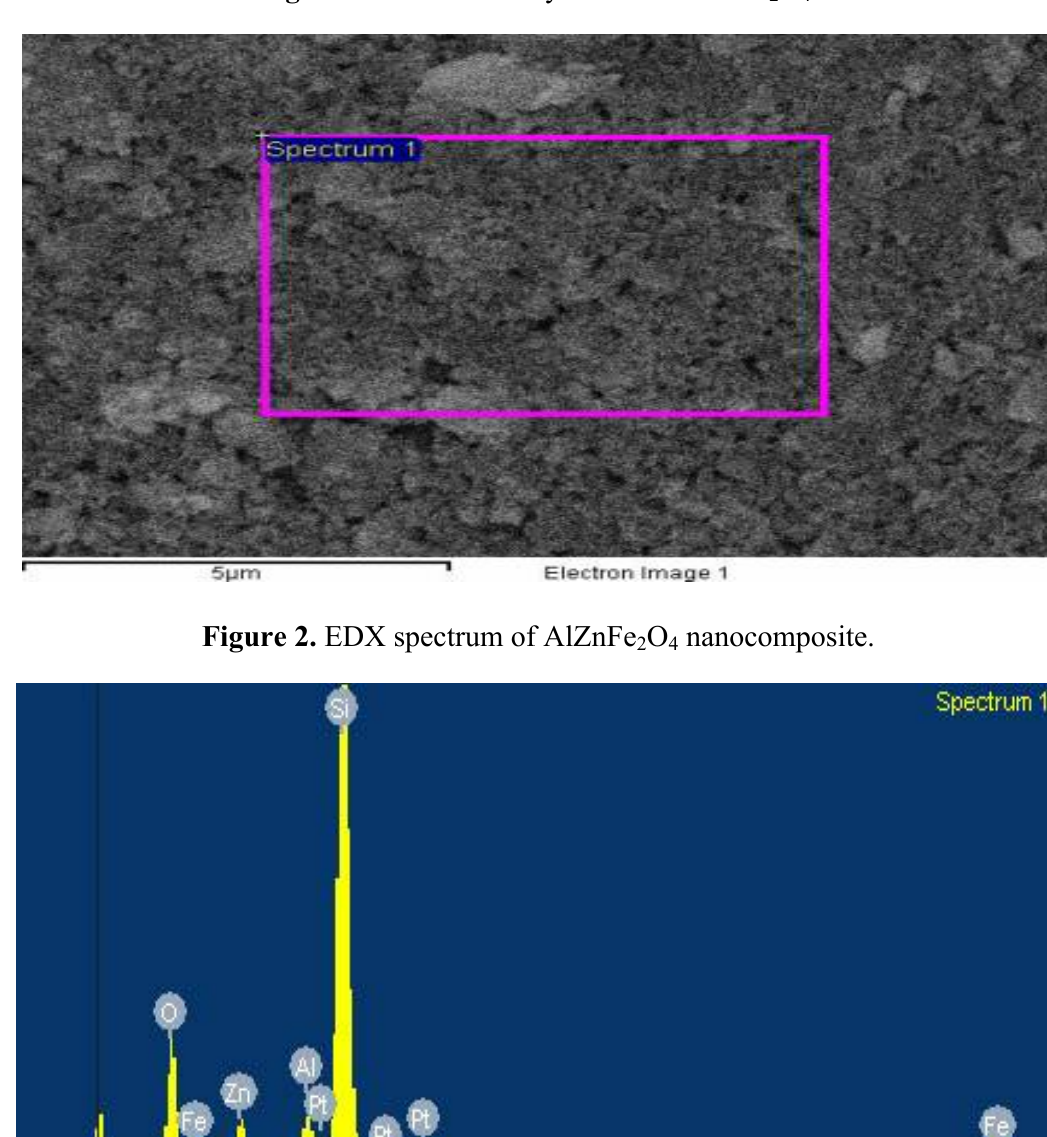
Figure 1. FE-SEM analysis of the AlZnFe